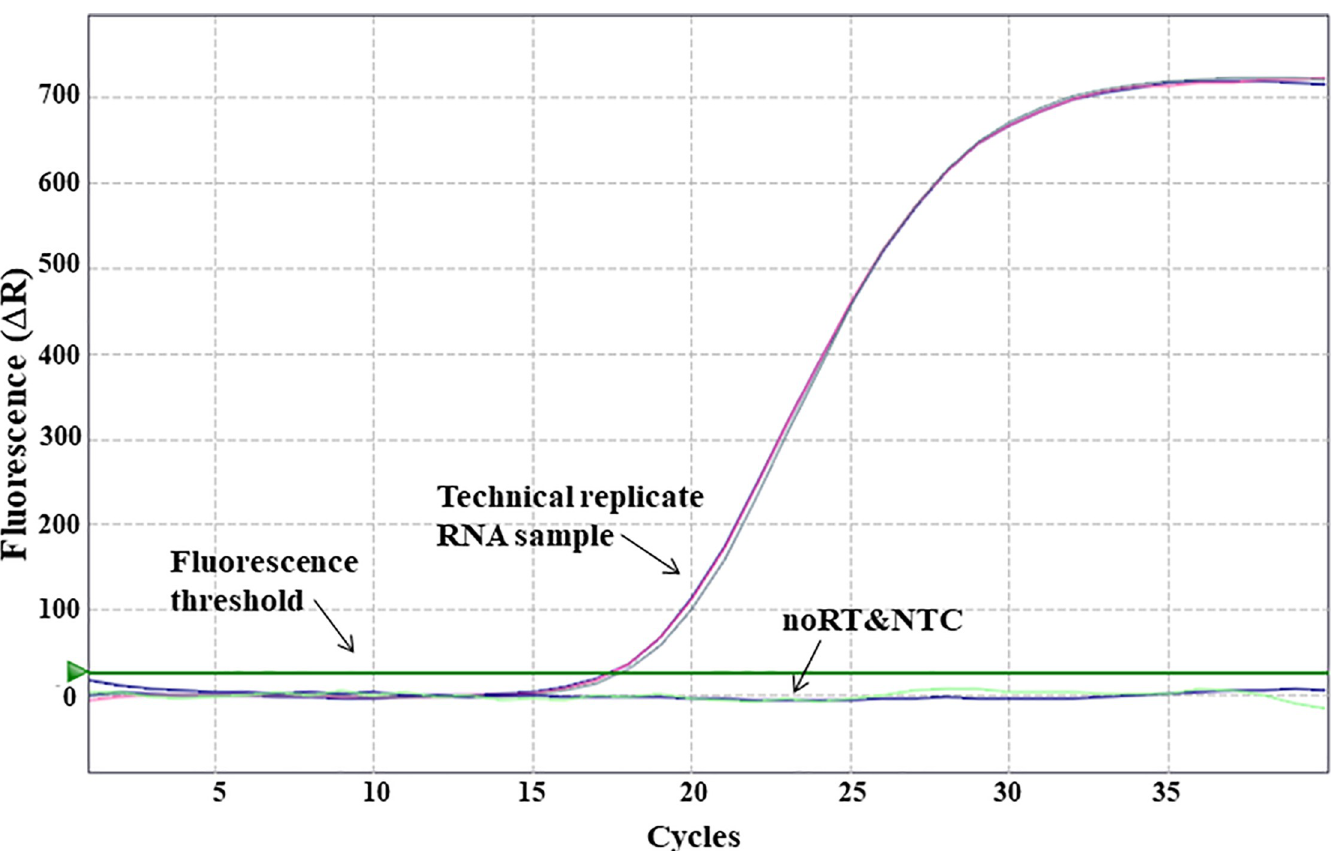
Fig 1. Exemplary amplification curve for standardized target genes: Threshold is set low enough to be within the exponential growth range but above the baseline. No background signals are visible above the baseline, and neither are samples run with no reverse transcriptase noRT or no template control NTC. Running samples were performed in triplicate to control technical